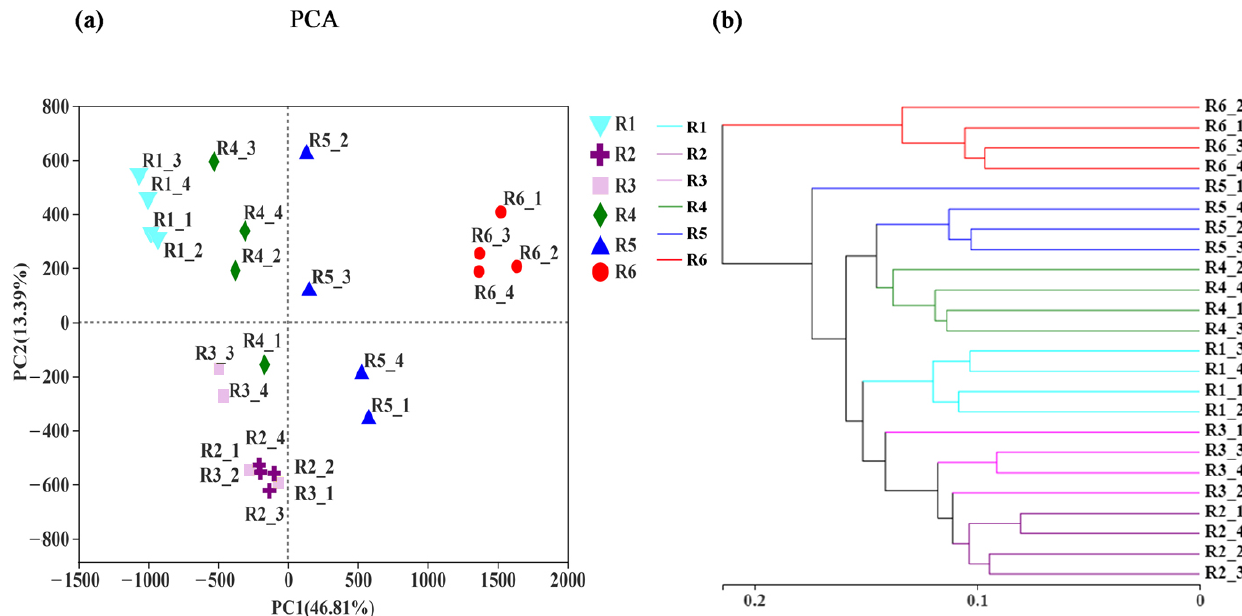
Figure 5. ( a ) Principal component analysis (PCA) and ( b ) clustering of samples. Bray–Curtis similarity index was calculated using OTU reads, and hierarchical clustering was calculated using the β-diversity distance matrix with QIIME. See Figure 2 for abbreviations.